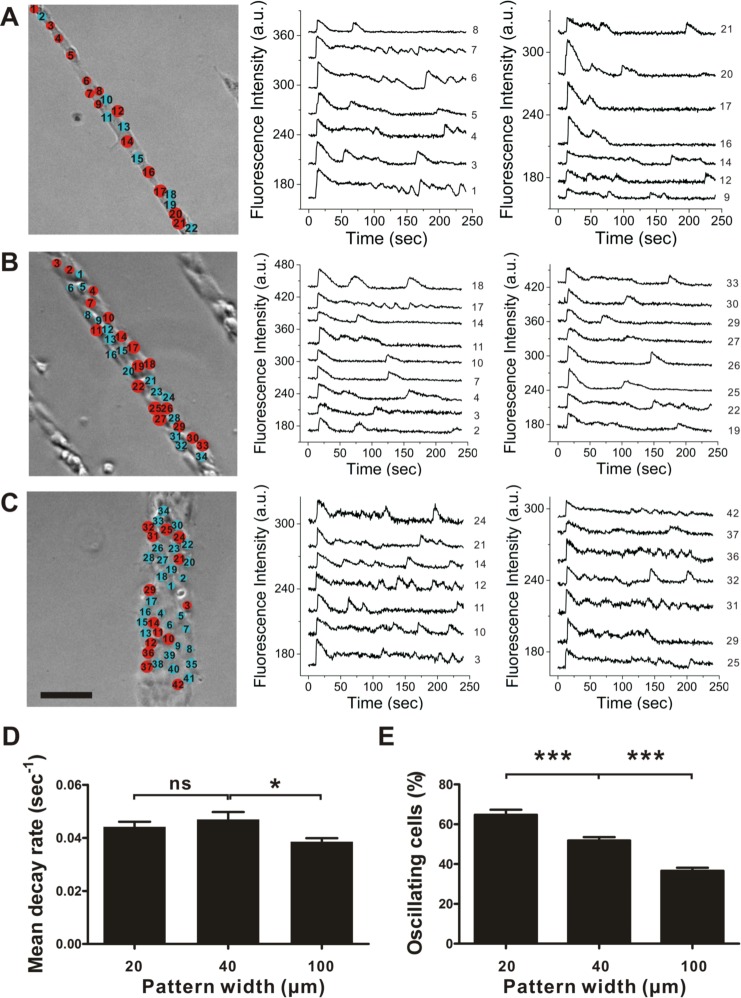
Collective calcium signaling depends on the number of coupled cells in linear networks.(A–C) Histamine-induced calcium oscillations in linear cell networks with the width of (A) 20 μm, (B) 40 μm and (C) 100 μm. Scale bar, 100 μm. Red circles indicate the oscillating cells. The calcium response curves were shifted vertically for clarity. (D-E) Quantification of the mean decay rate and calcium oscillation occurrence rate in linear cell networks with different widths (n = 8; 233 cells for 20 μm; 432 cells for 40 μm; 806 cells for 100 μm; Bonferroni's multiple comparison test; ns, not significant; *, P<0.05; ***, P<0.001).